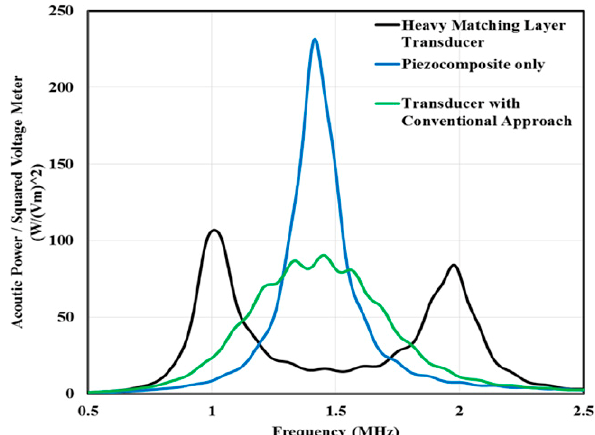
Figure 22. ( a ) Heavy matching layer transducer and ( b ) its internal configuration. Reproduced from [448] with permission from Copyright (2016) The Japan Society of Applied Physics.